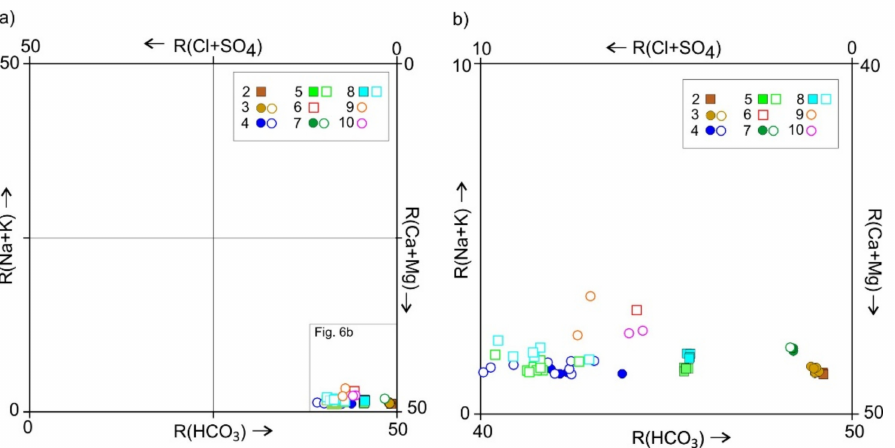
Figure 6. ( a ) The plot of the chemical composition of upper Nera River monitoring points (pre, filled symbols and post seismic, empty symbols) on the Langelier-Ludwig diagram. ( b ) Detail of the Langelier-Ludwig of referring to the box reported in ( a